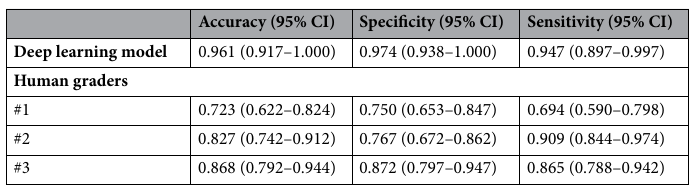
Table 2. The grading performance of the DL model comparing with three human graders using external testing datasets.